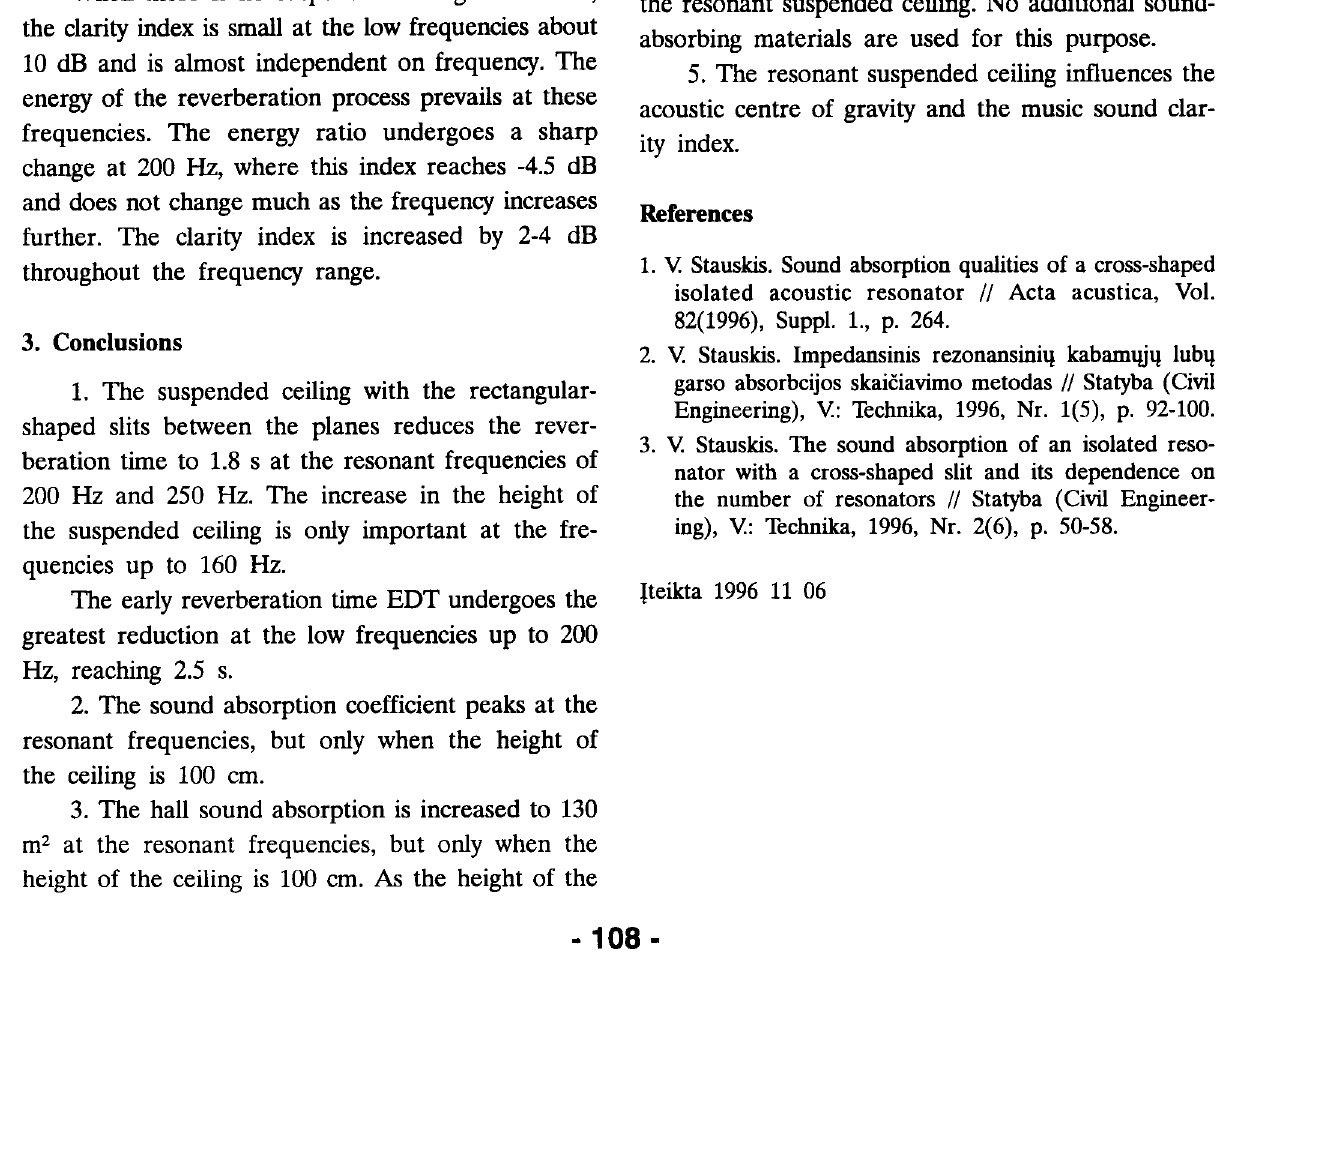
Fig. 10. The dependence of the musical sound's clarity index on on the distance from the resonant suspended ceiling to the rigid ceiling surface.Slit width 100 em. 1 - without resonant ceiling; 2 - distance to the rigid surface H = 100 em: 3 - 200 em: 4 - 400